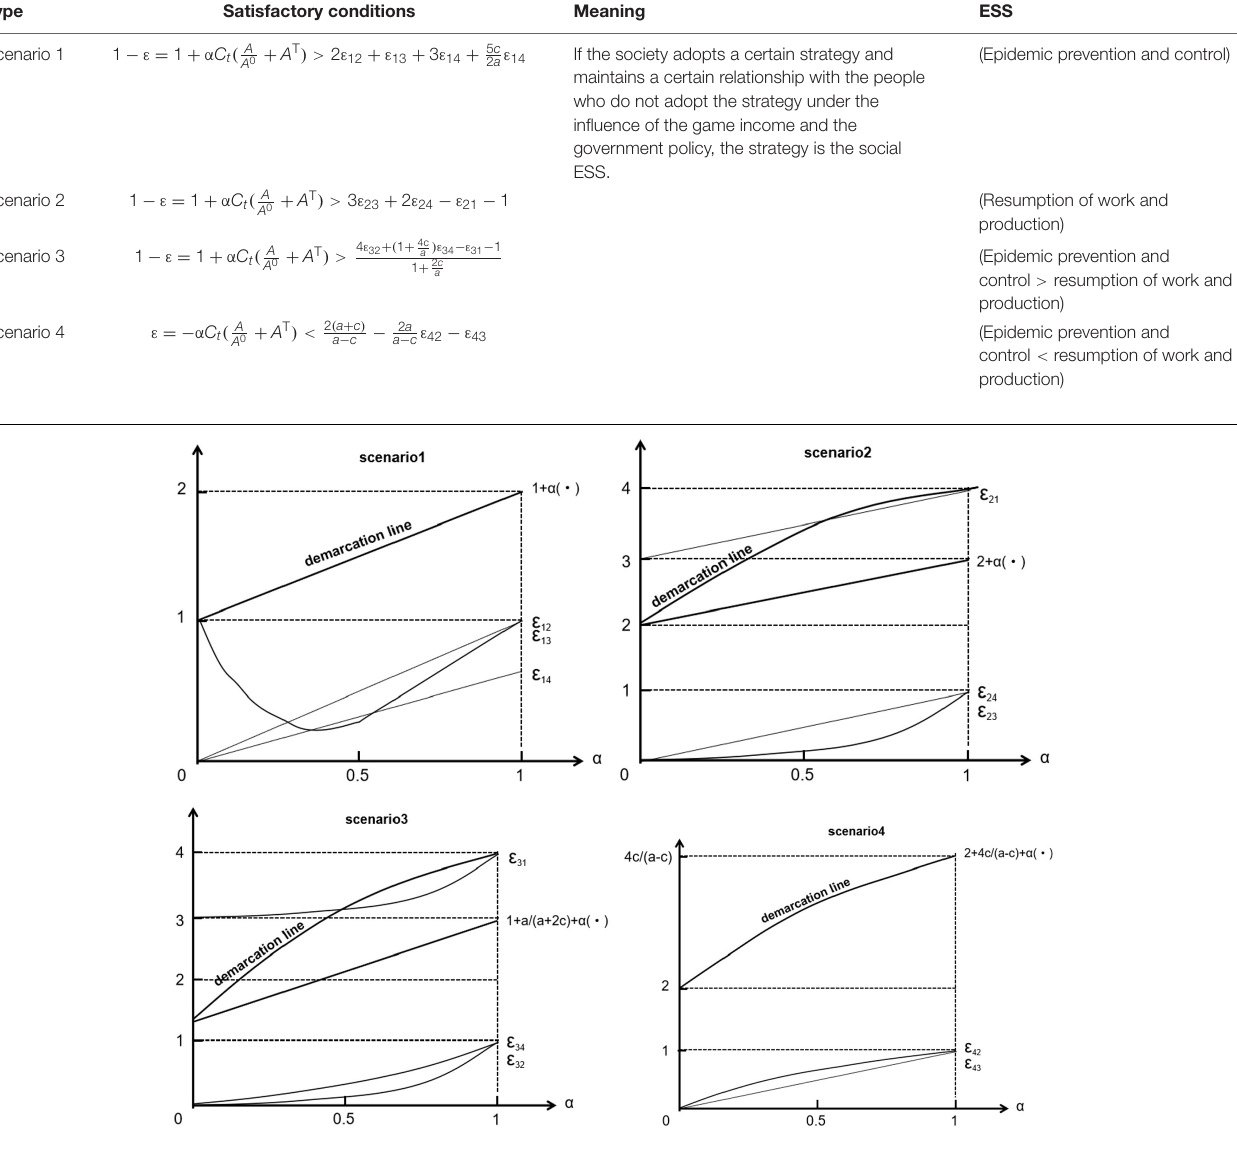
TABLE 4 | Game results for the entire society.